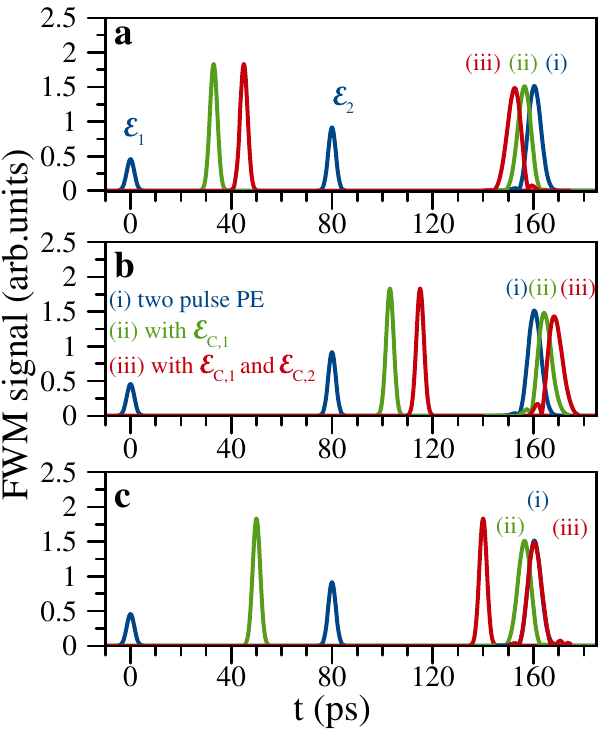
Fig. 5 Double pulse control of PE timing. Numerical simulation of PEs calculated using the optical Bloch equations. The fi rst and second pulses are depicted by the electric fi eld amplitudes E and E , and excite the quantum 1 2 dots at t = 0 and 80ps, respectively. The three PEs in all panels result from a different control pulse sequences: (i) no control pulse, (ii) the single control pulse with amplitude E C ; 1 , and (iii) two control pulses with amplitudes E C ; 1 and E are considered. The control pulses E and E are positioned at ( a ) C ; 2 C ; 1 C ; 2 t = 33 and 45ps (two pre-pulses), ( b ) t = 103 and 115ps (two post-pulses), and ( c ) t = 50 and 140ps (one pre-pulse and one post-pulse), respectively. For all simulations, Θ 1 = π /2, Θ 2 = π , and Θ C,1 = Θ C,2 = 2 π